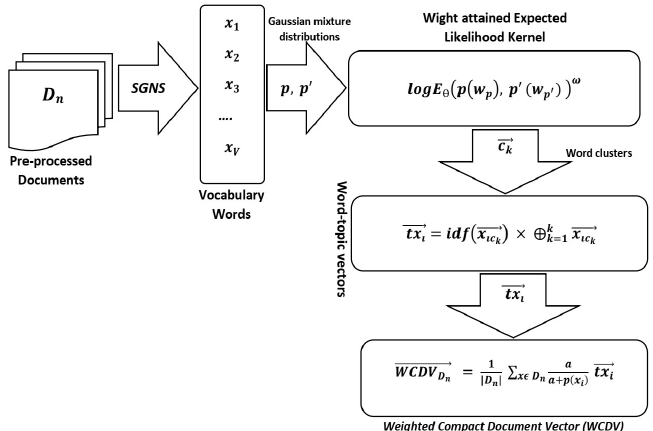
Figure 4. Weighted Compact Document Vector formation in to d × k dimensional embedding